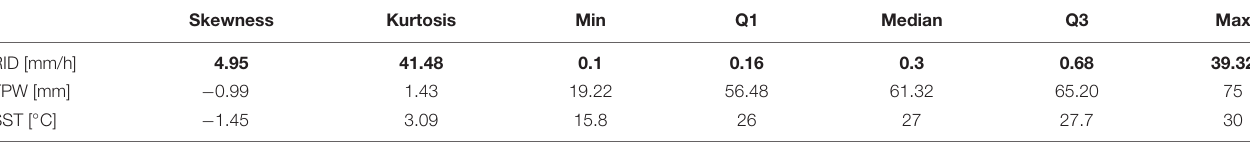
TABLE 1 | RID, TPW, and SST main statistical